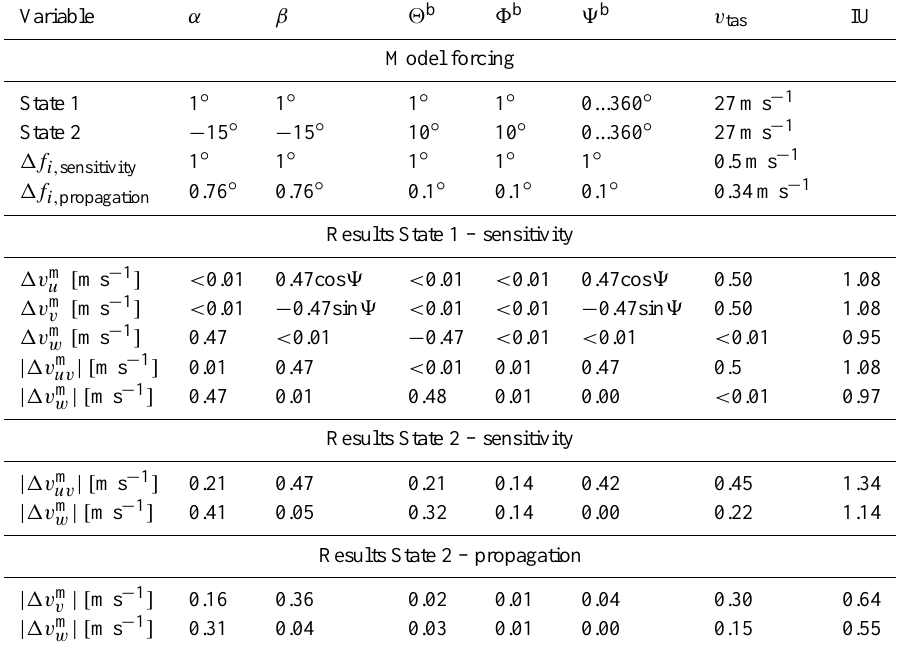
Table 4. Input uncertainty (IU) from the linear uncertainty propagation model Eq. (B1). For the sensitivity analysis the model was forced with two different reference states, State 1 with small and State 2 with enhanced flow ( α , β ) and attitude ( 2 b , 8 b , 9 b ,) angles. Both states were inferred similar uncertainty quantities 1f i in α , β , 2 b , 8 b , 9 b , and true airspeed ( v tas ). After calibration step B the reference State 2 was used for the uncertainty propagation: the actual uncertainties in (a) the flow computation ( α , β and v tas , Table 5), and (b) the sensor alignment ( 2 b , 8 b , 9 b ) were inferred. Additional information is given in Sect.